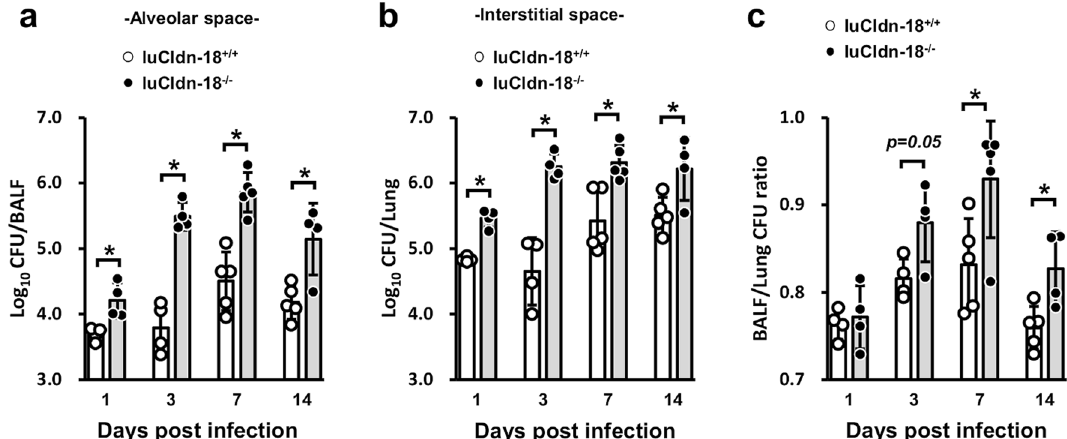
Figure 3. Effect of luCldn-18 deficiency on the localization of C. deneoformans. luCldn-18 +/+ (day 1, n = 4; day 3, n = 4; day 7, n = 5; day 14, n = 5) and luCldn-18 −/− mice (day 1, n = 4; day 3, n = 4; day 7, n = 5; day 14, n = 4) were infected intratracheally with C. deneoformans. The numbers of live colonies in BALFs ( a , alveolar space) and lung interstitial homogenates after BAL ( b , interstitial space) on days 1, 3, 7, and 14 post-infection were counted. ( c ) The ratio of the number of live colonies in BALFs to the number in the lungs was calculated for each mouse. Each symbol represents a separate mouse, and bars indicate the mean ± SD. *, p < 0.05. There were no mice excluded from this